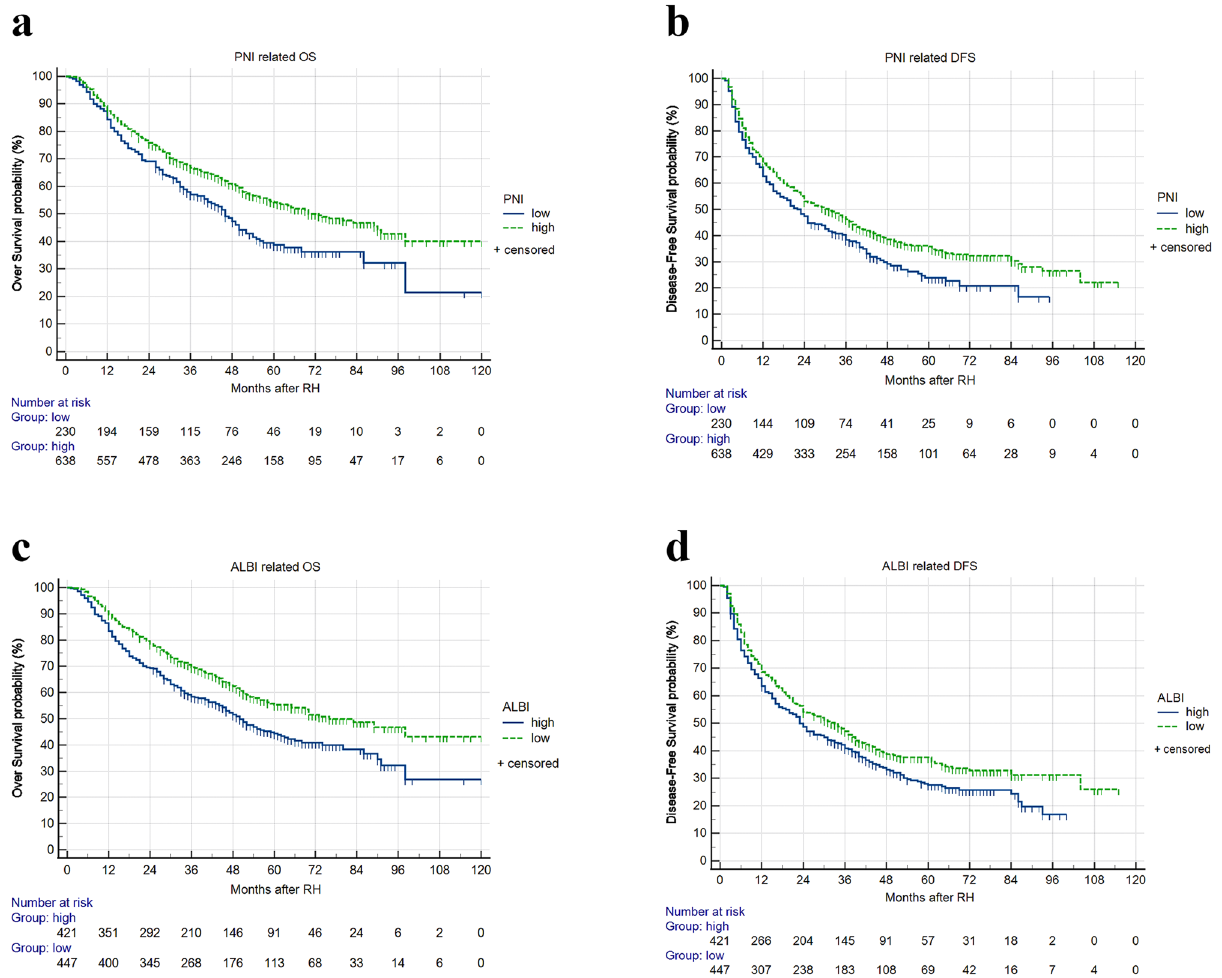
Figure 2. Relationship between PNI or ALBI and DFS or OS of HBV-HCC patients undergoing RH. ( a ) OS of patients with PNI > 46 was higher thant hose with PNI ≤ 46 (P < 0.01). ( b ) DFS of patients with PNI > 46 was higher than those with PNI ≤ 46 (P < 0.01). ( c ) OS of patients with ALBI ≤ -2.8 was higher than those with ALBI > -2.8 (P < 0.01). ( d ) DFS of patients with ALBI ≤ -2.8 was higher than those with ALBI > -2.8 (P <